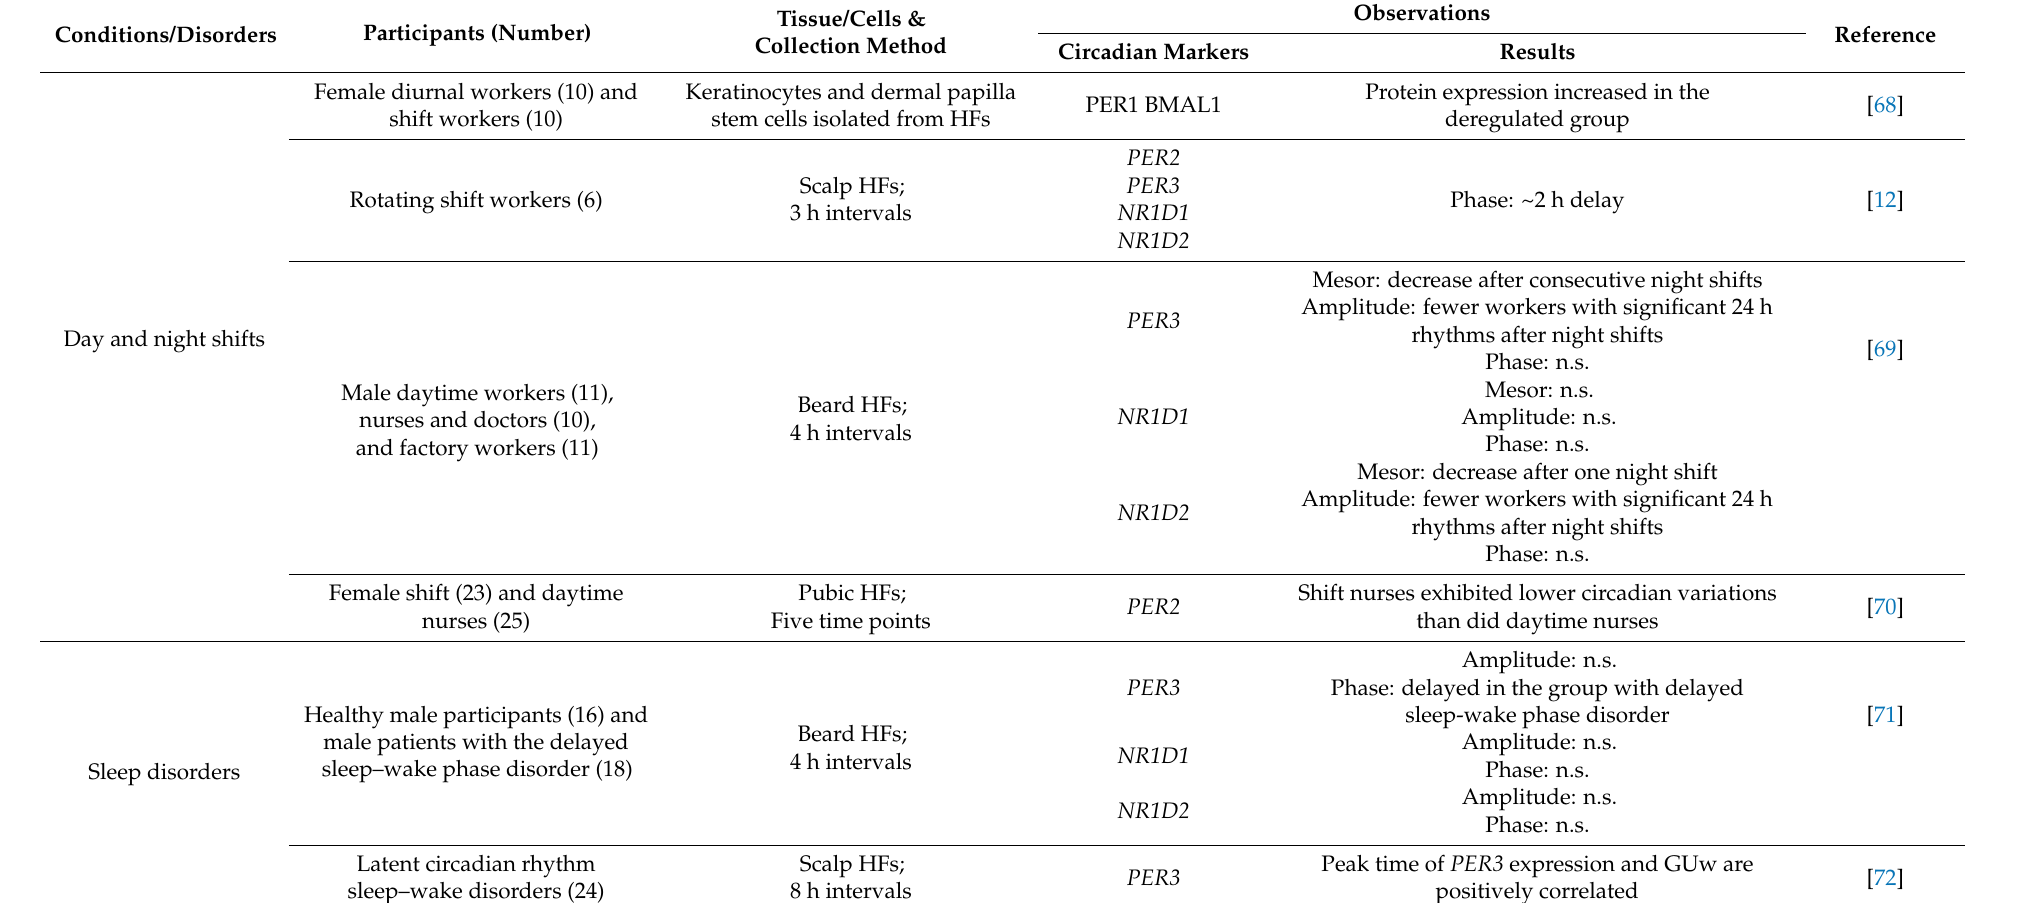
Table 1. Evaluation of the circadian rhythm in various conditions and disorders using human hair